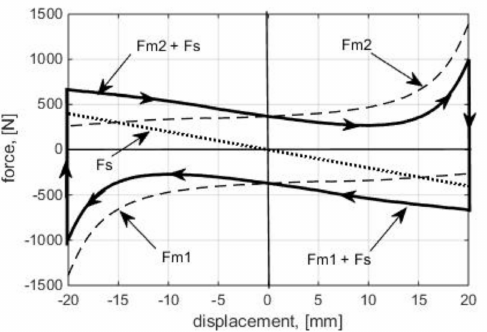
Figure 10. The magnetic forces F m and spring force F s acting on the upper (1) and lower (2) motor pistons at 20 A coil